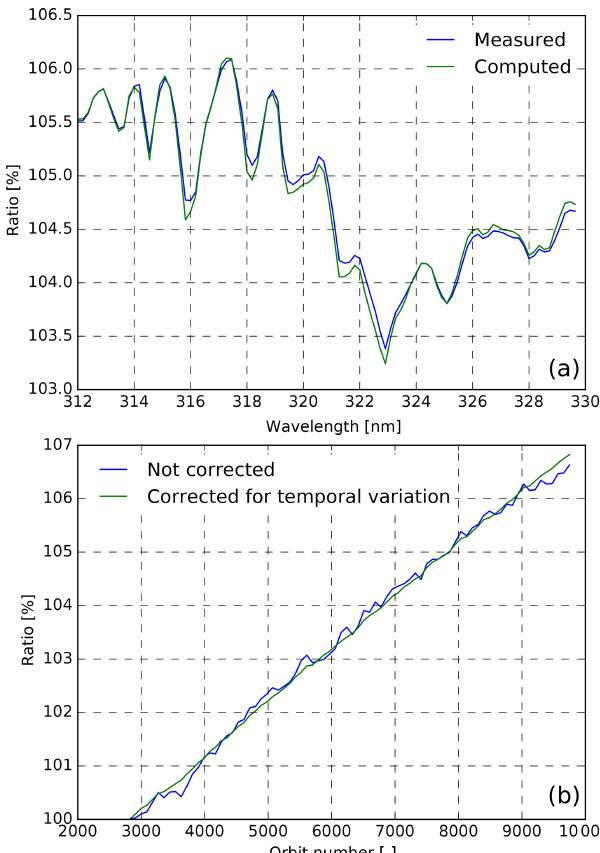
Figure 12. (a) Spectral degradation in the UV spectrometer from measured irradiance ratios between band 2 and band 3 (blue) and D spec as computed from the model (green) for orbit 8849. The other model contributions are not included here. (b) Evolution of the ra- tio of measured signals at 317nm, with (green) and without (blue) correction of the temporal variation ratios. Note the constant rate of increase of 1% per 1000